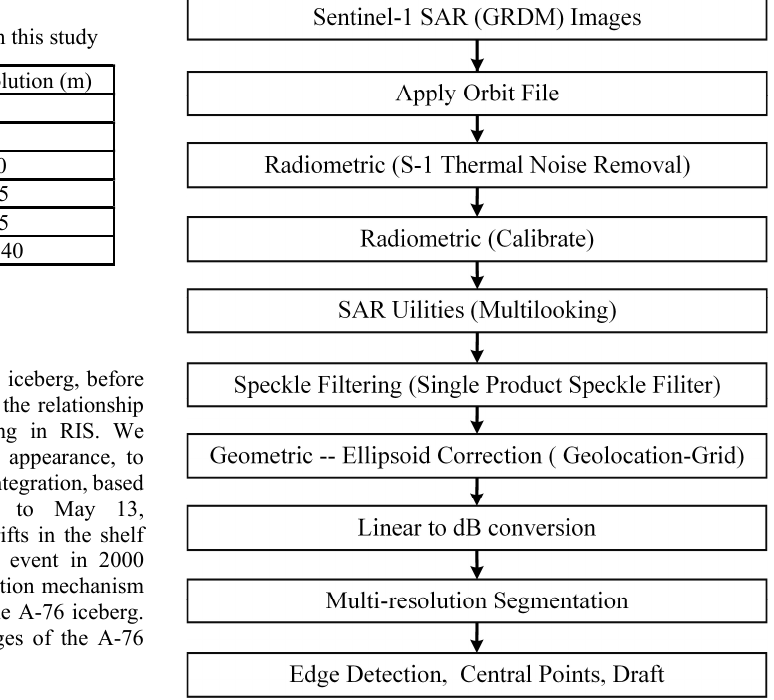
Figure 2. The workflow of A-76 (including A-76A, A-76B, and A-76C) iceberg extraction and